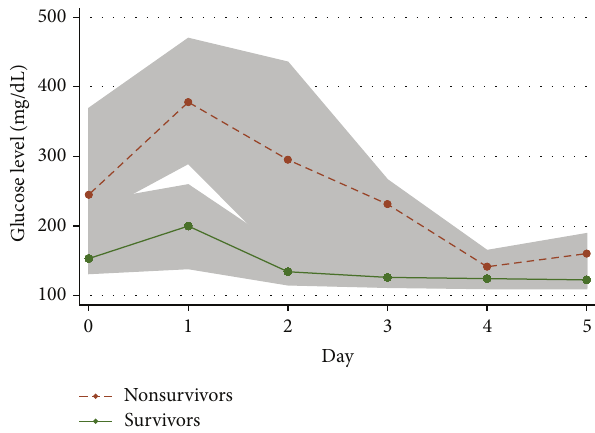
Figure 2: Glucose levels for survivors versus nonsurvivors over time. The points signify the median glucose levels and the shaded area signifies the interquartile